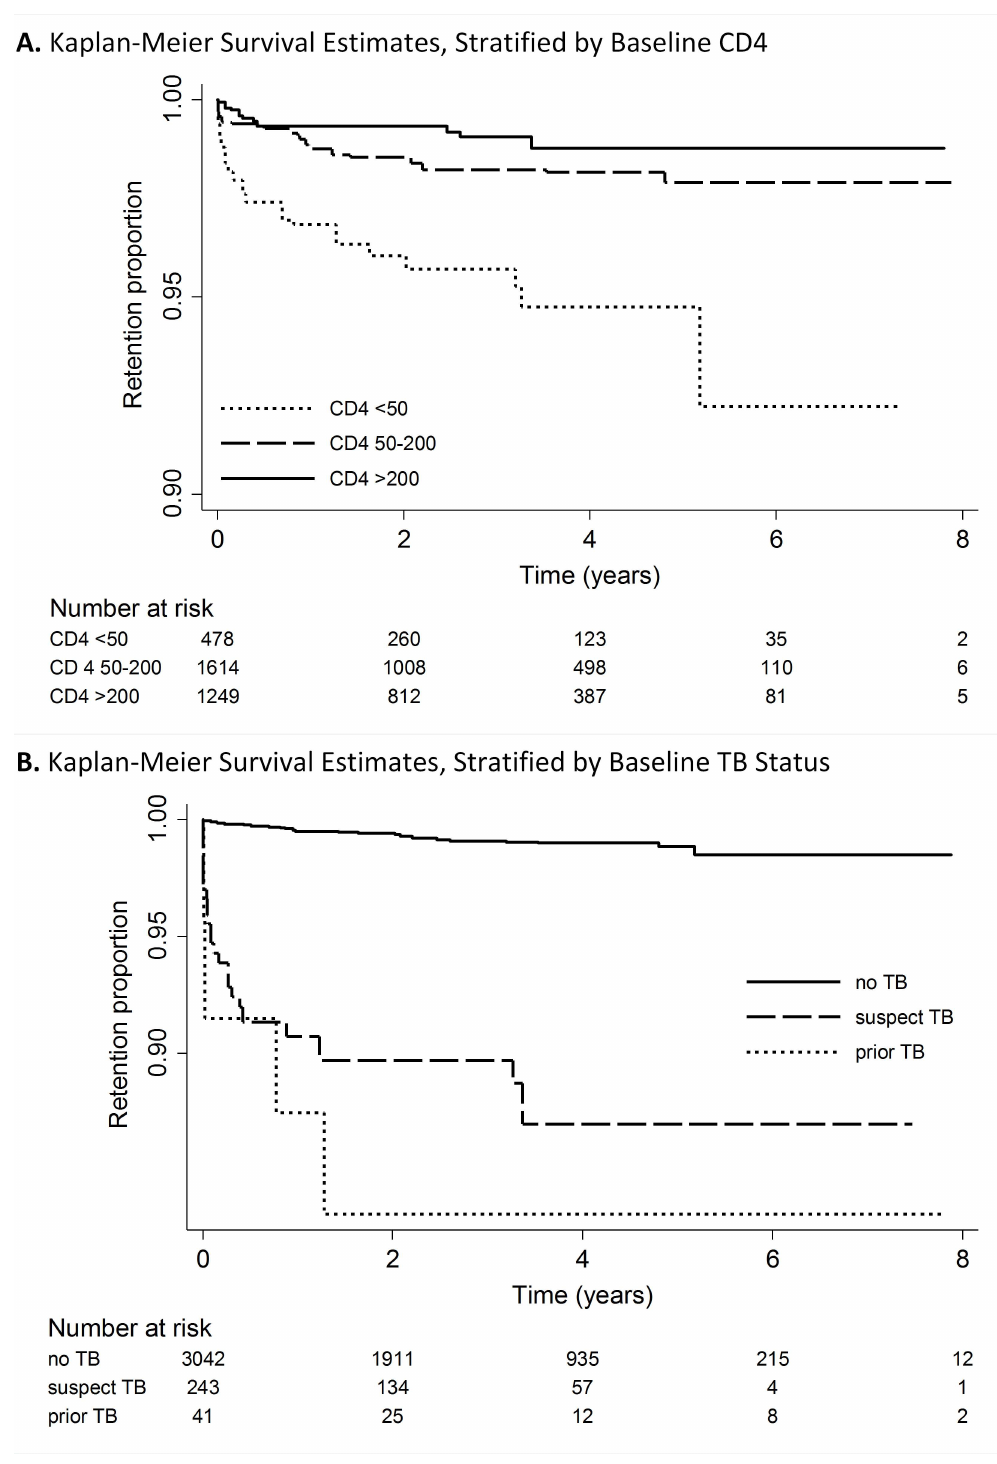
Fig 2. Kaplan Meier Survival Analysis of TB-Free Survival, Stratified by Baseline: A. CD4 count; B. TB status. (Survival analysisrun on imputation#1 of 20).